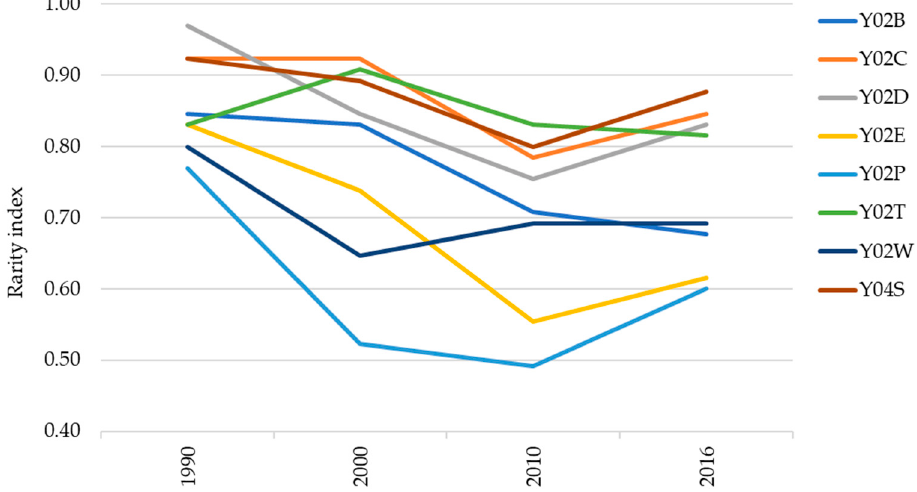
Figure 2. Rarity ( (cid:1837) (cid:3047) ) in CCMT-TPFs by CPC class (2000, 2010, 2016; 5-year MA).